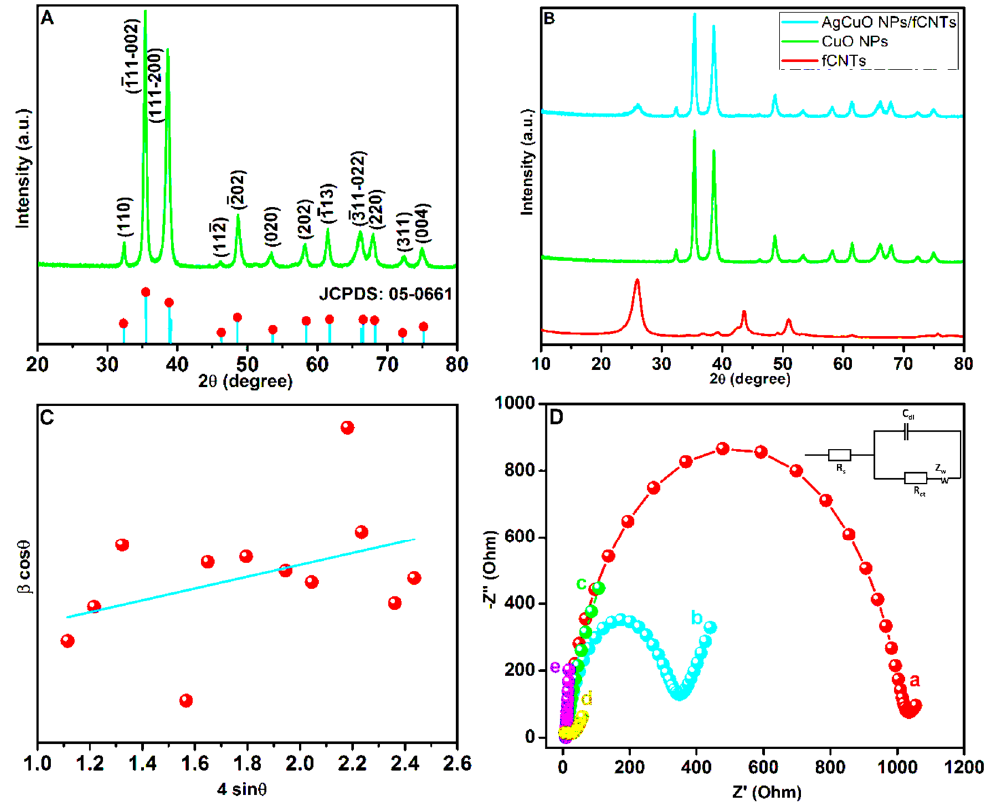
Figure 1. XRD: ( A ) CuO; ( B ) AgCuO NPs/fCNTs, CuO, and fCNTs. ( C ) Williamson–Hall plot of CuO. ( D ) Nyquist plot of bare SPCE (a), CuO/SPCE (b), fCNTs/SPCE (c), AgCuO NPs/SPCE (d), and AgCuO NPs/fCNTs/SPCE (e).